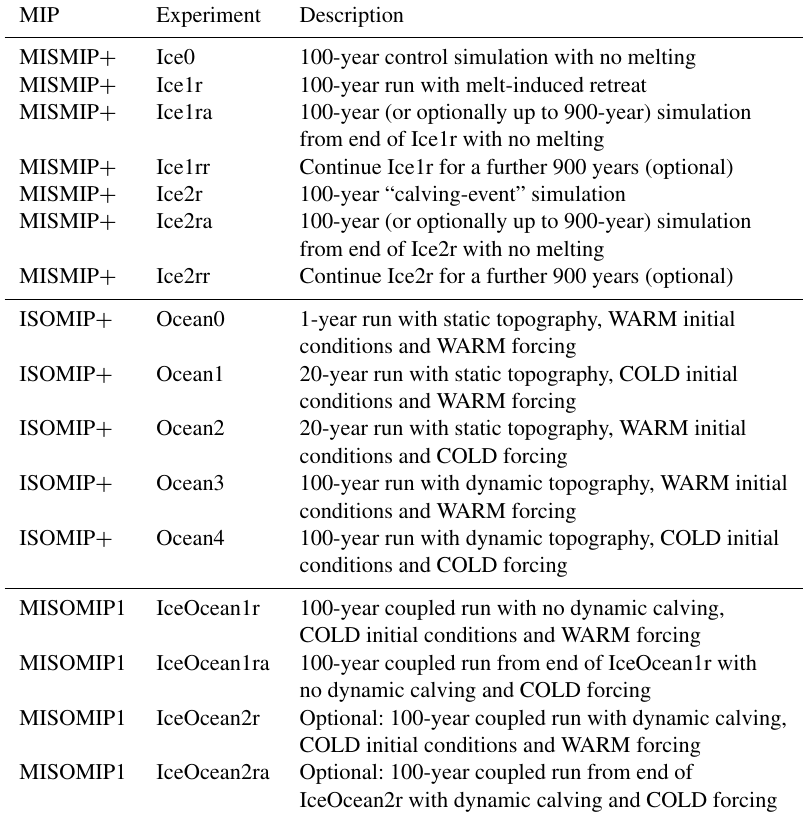
Table 2. List of the MISMIP + , ISOMIP + and MISOMIP1